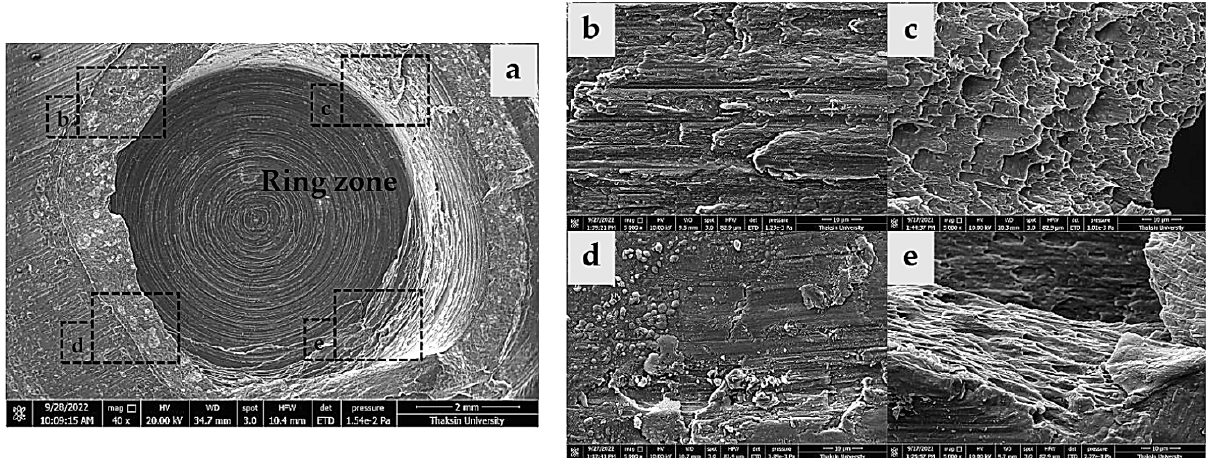
Figure 8. Characteristics of the failure fracture surface in the ring zone: ( a ) overall view of the shear fracture surface, ( b ) initial crack zone, ( c ) ductile fracture zone; ( d ) crack propagation zone; and ( e ) overload crack zone.